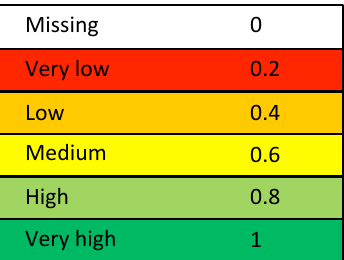
Figure 5. Content depth—Categories and